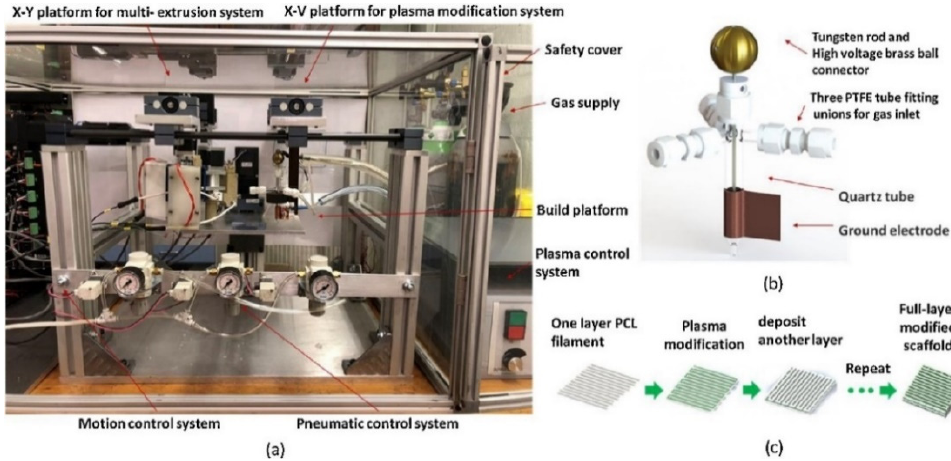
Figure 13. ( a ) Plasma-assisted bioextrusion system (PABS) 3D printer unit; ( b ) plasma modification unit; ( c ) sequence of operation for PABS 3D printing of bio-scaffold. Reproduced with permission from [223]. Copyright (2018) Elsevier.